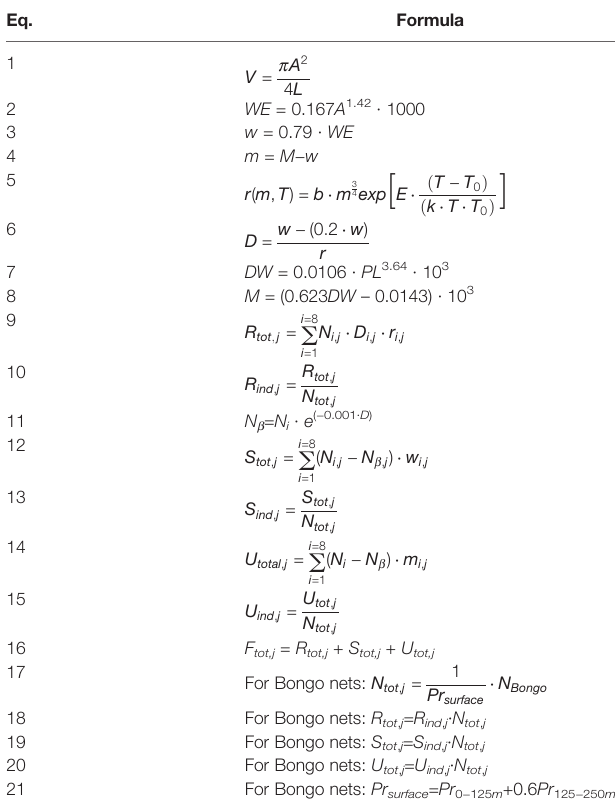
TABLE 3 | Equations used to determine body condition factors, respiration rates, mortality rates and rates of C fl ux that contribute to the lipid pump.